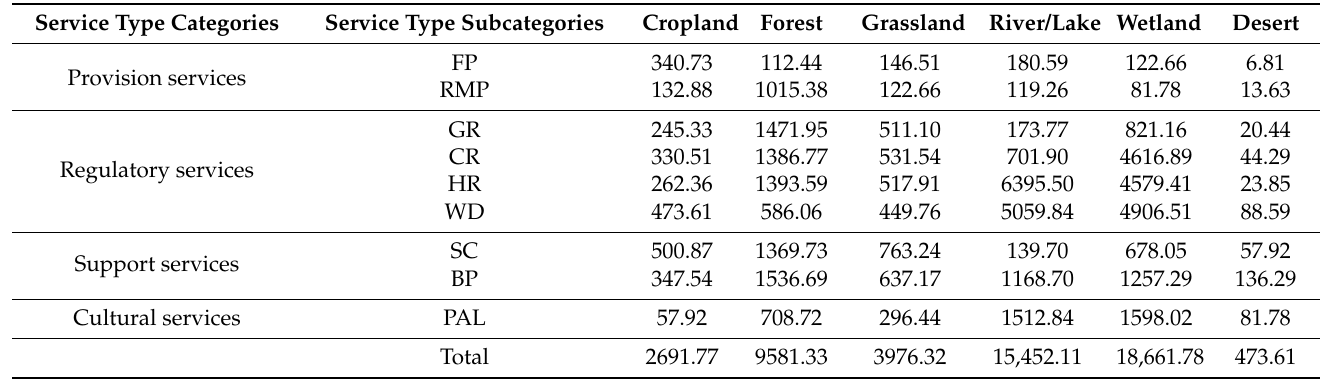
Table 2. ESV per unit area of ecosystem after correction in Xinjiang (unit: USD/ha) (2020